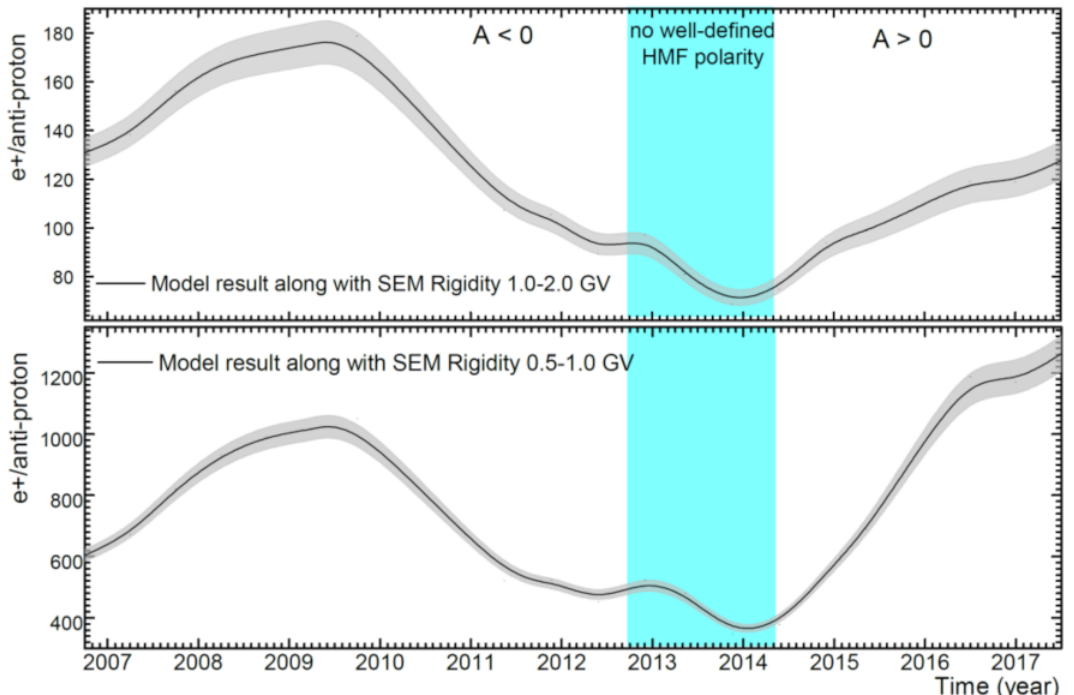
Figure 23. Examples of the simulated positron ( e +) to anti-proton ratio as a function of time, from 2007 to 2017, at 1.0–2.0 GV ( top panel) and 0.5–1.0 GV ( bottom panel). Shaded grey bands indicated the standard error of mean (SEM; standard √ deviation/ n). Vertical shaded band is the same as used before. How solar activity has progressed over this period, is shown in Figure